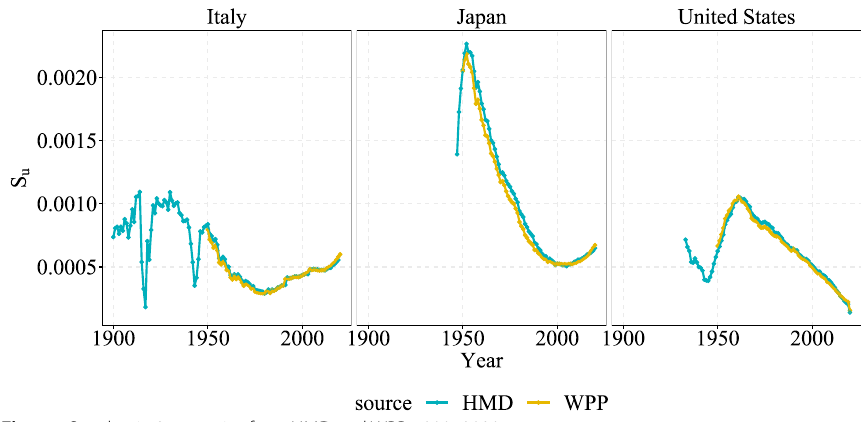
Fig. 11 S u value in 3 countries from HMD and WPP, 1900–2020